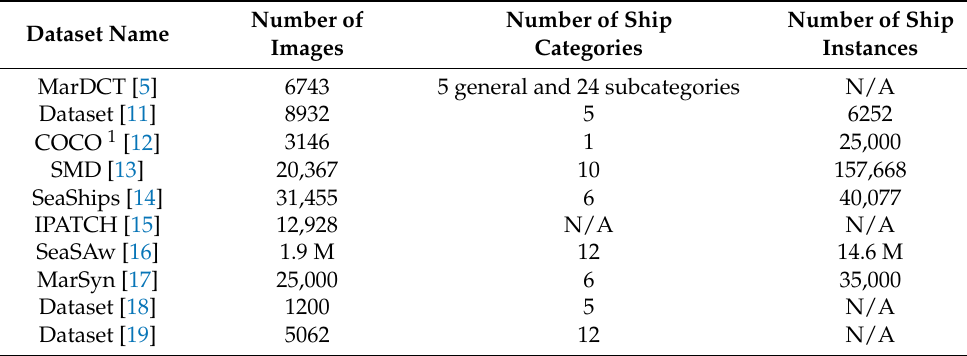
Table 1. Number of images, ship categories, and instances within the